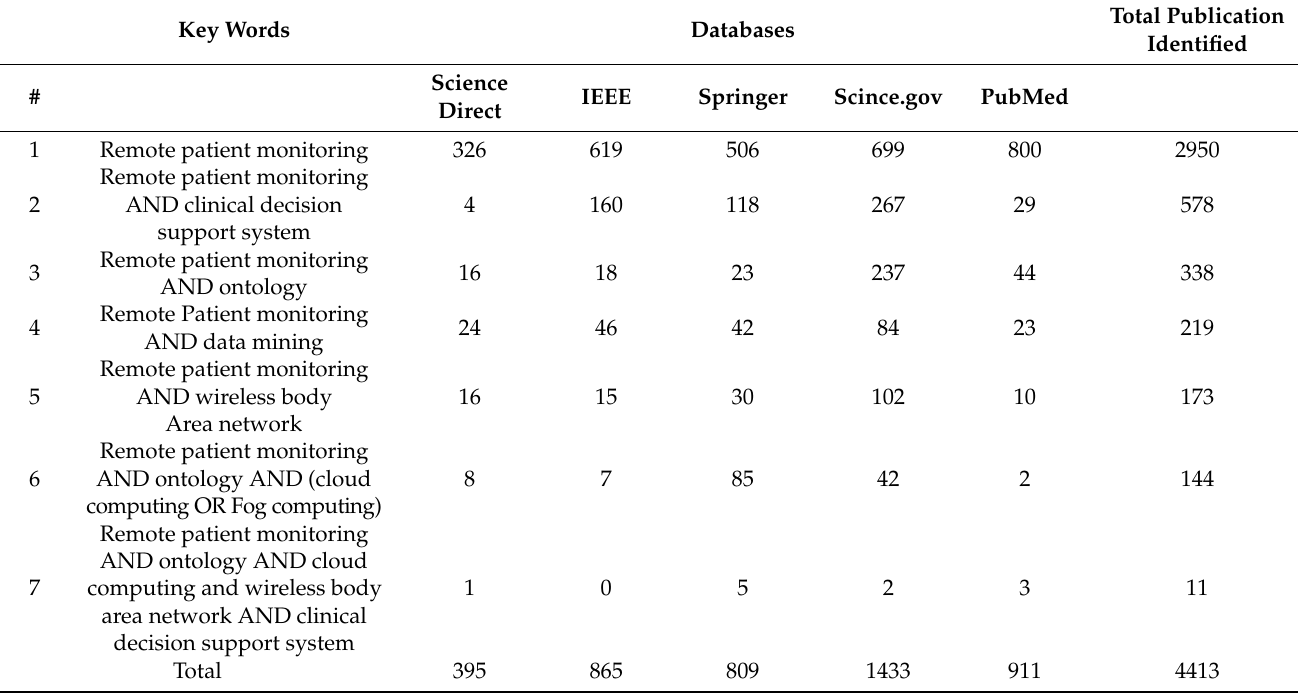
Table 1. Keywords used to obtain eligible articles.